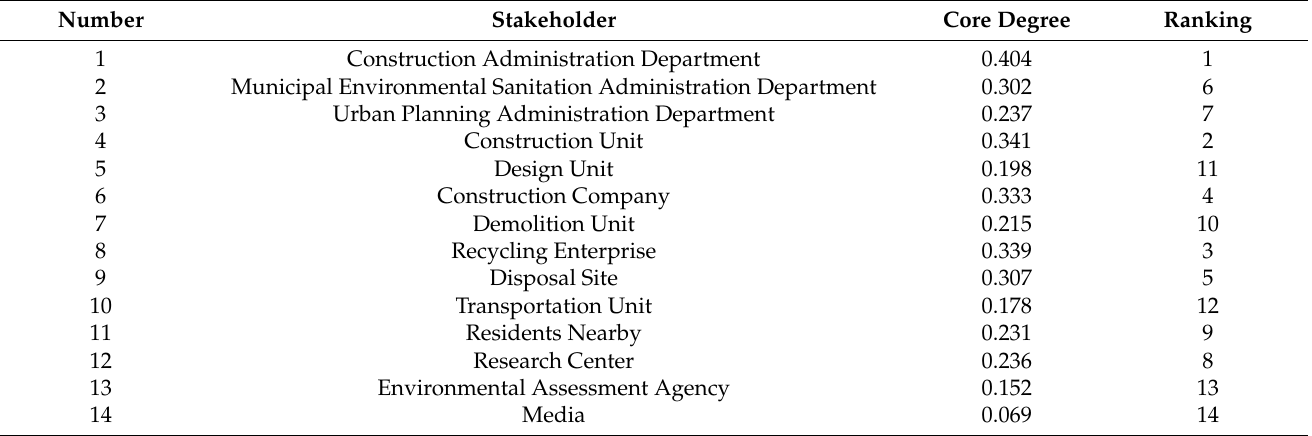
Table 7. Core Degree of